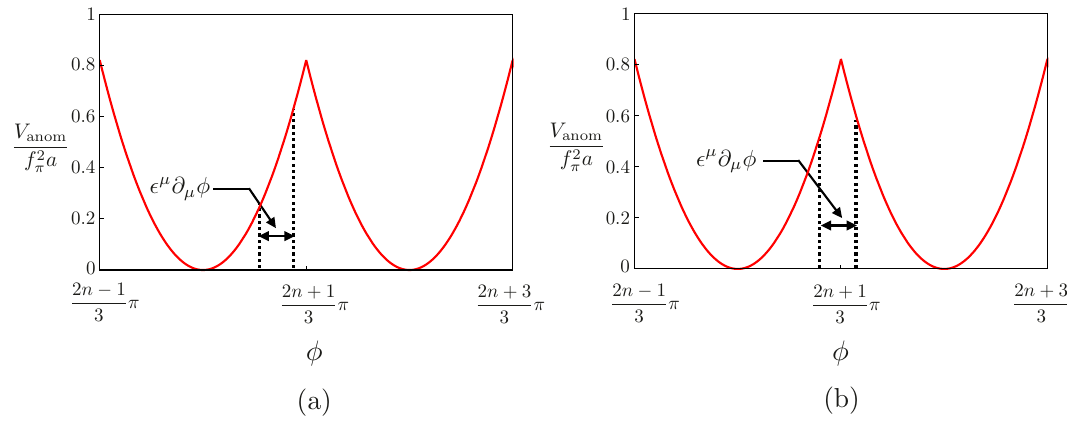
Figure 2 . (a) Both (cid:30) and (cid:30) + (cid:14)(cid:30) are between (2 n